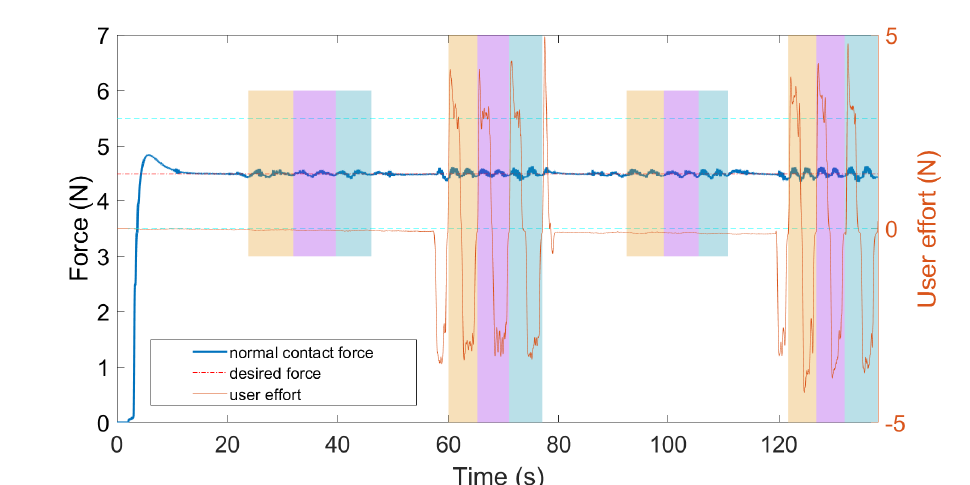
Figure 7. Sample data for dual-mode switching test using a “1-2-1-2” switching sequence in Exper- iment 3. Each color bar period represents a trial. Two short color bar areas represent the tele HRI mode, while two long color bar areas represent the p HRI mode. Two horizontal cyan lines define the tolerance area for the desired force.